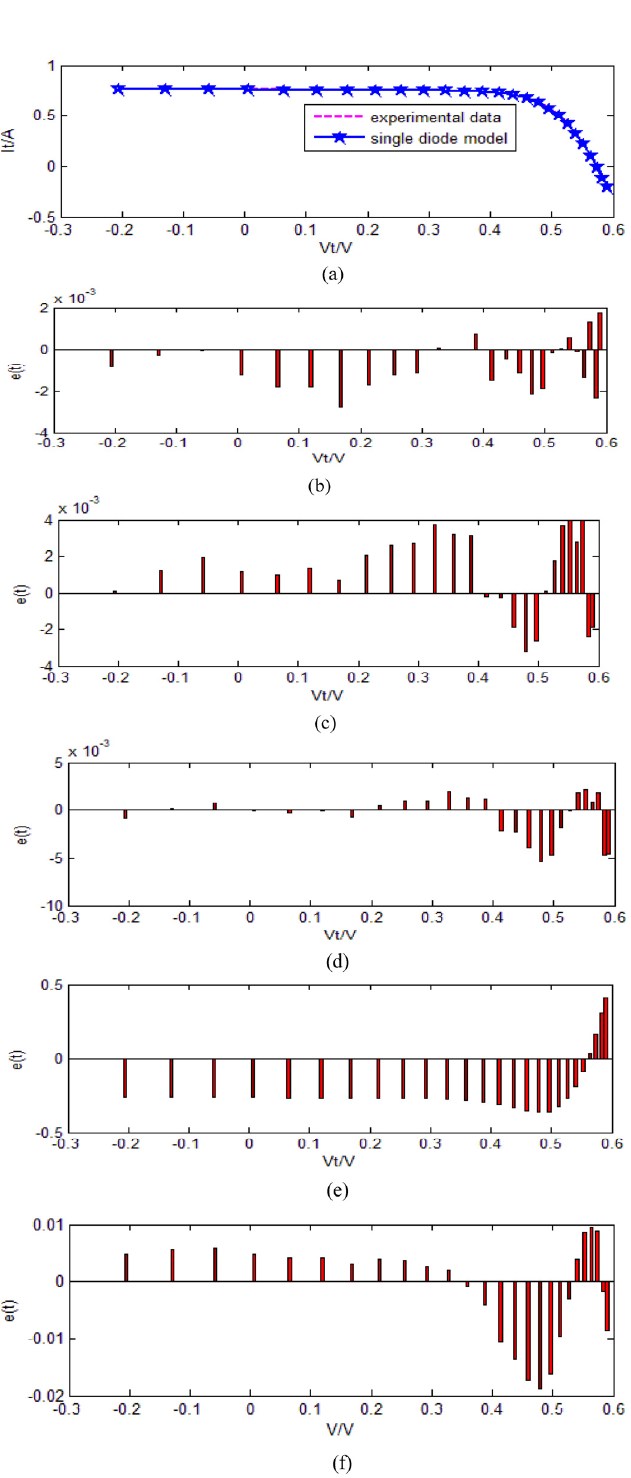
Figure 6. The comparison of the results of four methods for the single diode model: ( a ) comparison between the I - V characteristics generated using our proposed method and the measured data; ( b ) relative error for each measured value based on the identified parameters using IABC algorithm; ( c ) relative error for each measured value based on the identified parameters using ABC algorithm; ( d ) relative error for each measured value based on the identified parameters using DE algorithm; ( e ) relative error for each measured value based on the identified parameters using PSO algorithm; ( f ) relative error for each measured value based on the identified parameters using ABSO